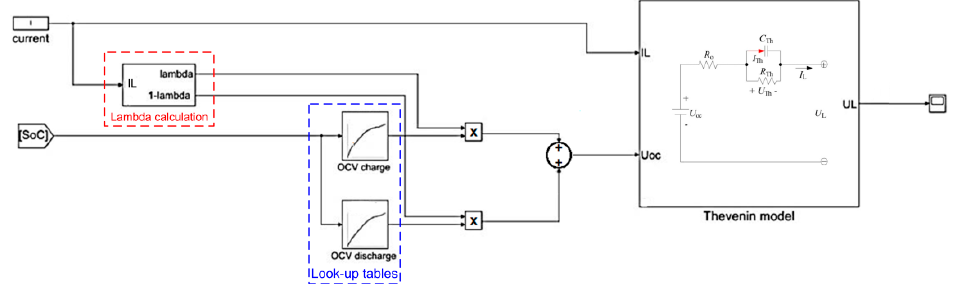
Figure 2. Model of the battery module (implemented in the Matlab/Simulink